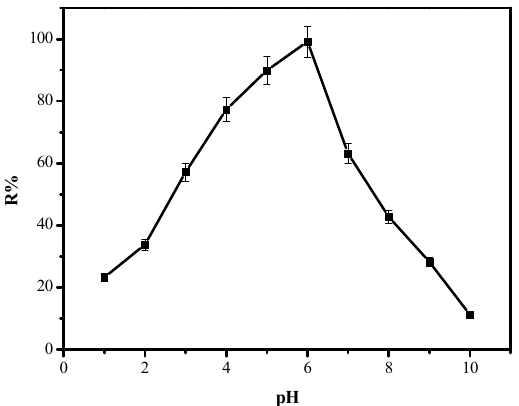
Figure 7. Effect of pH on the efficiency of the GA/MNP composite for the removal Pb(II) from an aqueous solution at 298 K.